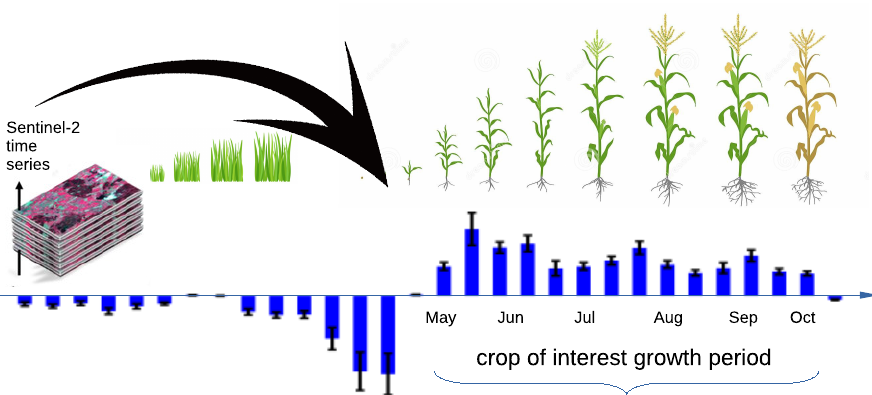
Figure 1. Representation of proposed technique for class activation interval (CAI). The fully convolu- tive CNN trained for image segmentation is able to identify time intervals of the input time series that determines class presence. The CAI can be computed in a single forward step: for the class maize results show data relevance from May to